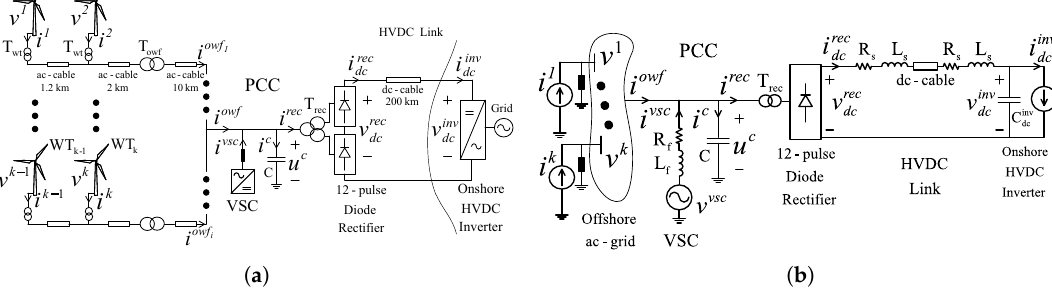
Figure 1. System under study: ( a ) The considered offshore wind farm (OWF); ( b ) system simplified